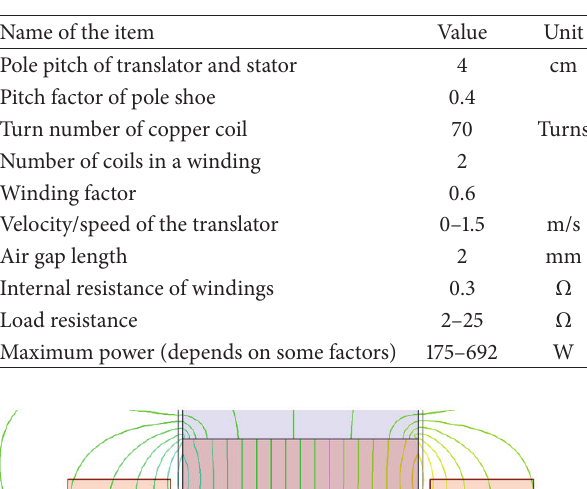
Table 5: The parameters of the PMLG.